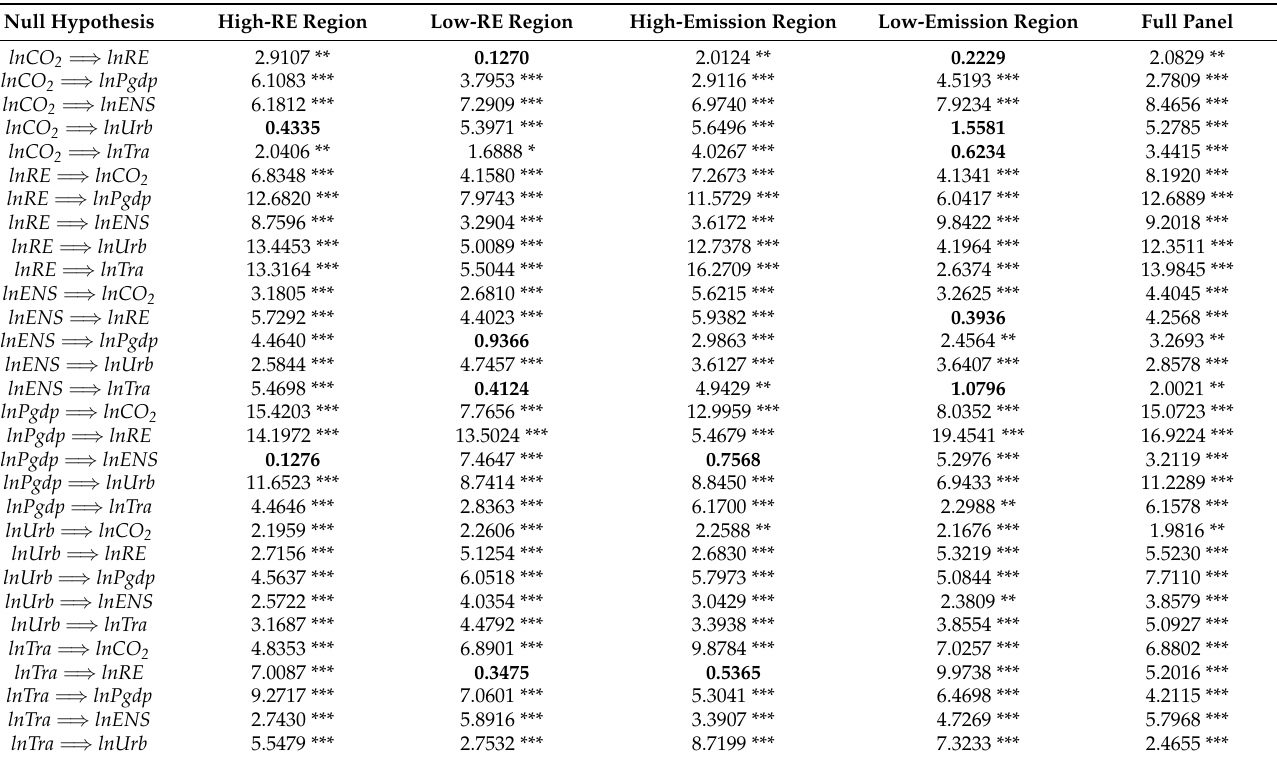
Table 9. Results of the D-H panel causality